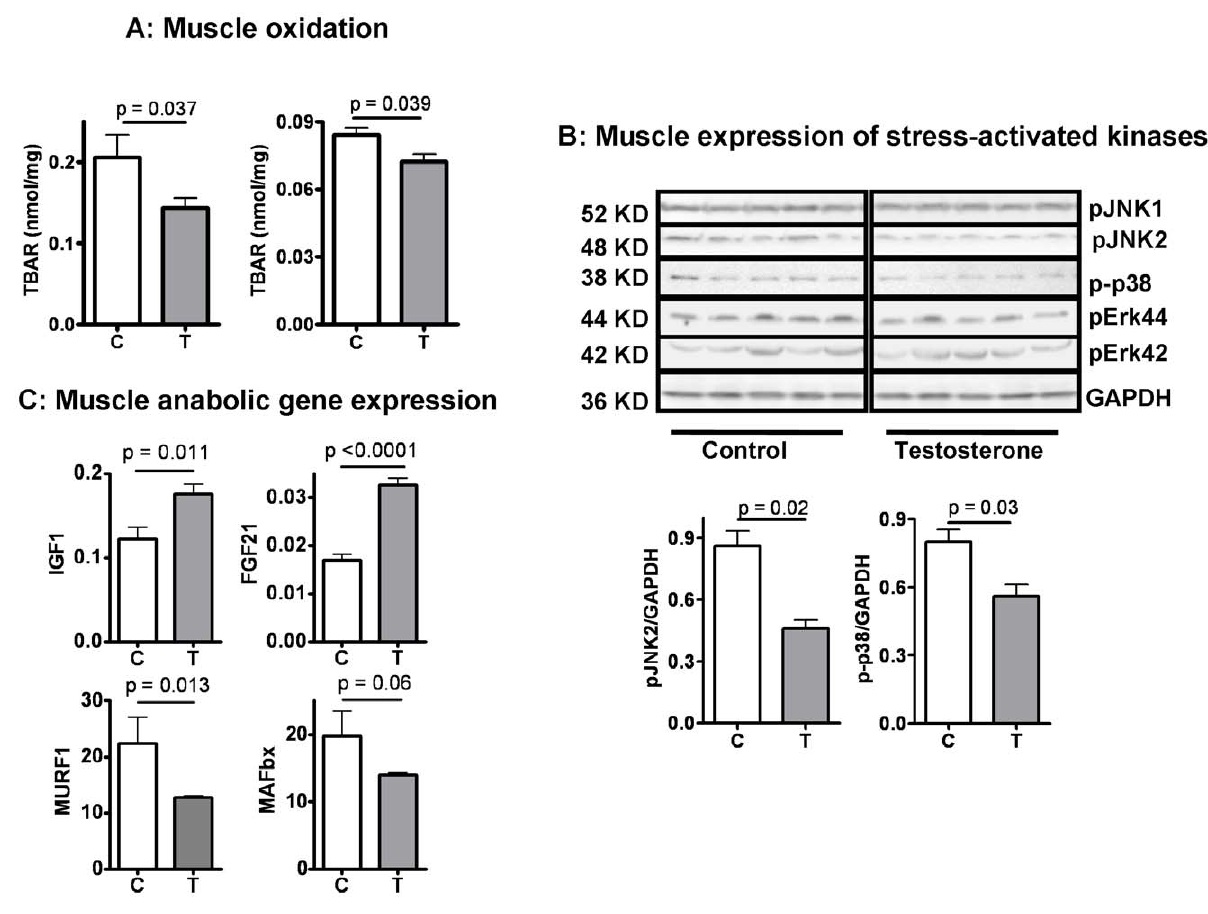
Figure 5. Effect of testosterone supplementation plus low-intensity physical training on protein oxidation/carbonylation and phosphorylation/activation of stress-activated kinases in skeletal muscle. ( A ) Testosterone reduced skeletal muscle thiobarbituric acid reactive substance (TBAR) in quadriceps (left) and gastrocnemius (right) muscle homogenates, implying a reduction in tissue oxidant stress. ( B ) Testosterone reduced phosphorylation of the two stress-activated protein kinase JNK2 and p38, without affecting the mitogen-activated Erk42/44; serving as a second line of evidence for a reduction in tissue stress in response to testosterone supplementation plus low-intensity physical training interventions. ( C ) Testosterone increased mRNA expression of IGF1 and FGF21 while reduced mRNA expression of MURF1 and MAFbx in skeletal muscle (triceps). The data in the bar graphs are mean 6 SEM and analyzed by t test. N=5 for the control (C) group and 8 for the testosterone (T) group (for visual clarity, only five are displayed for each group in the Western